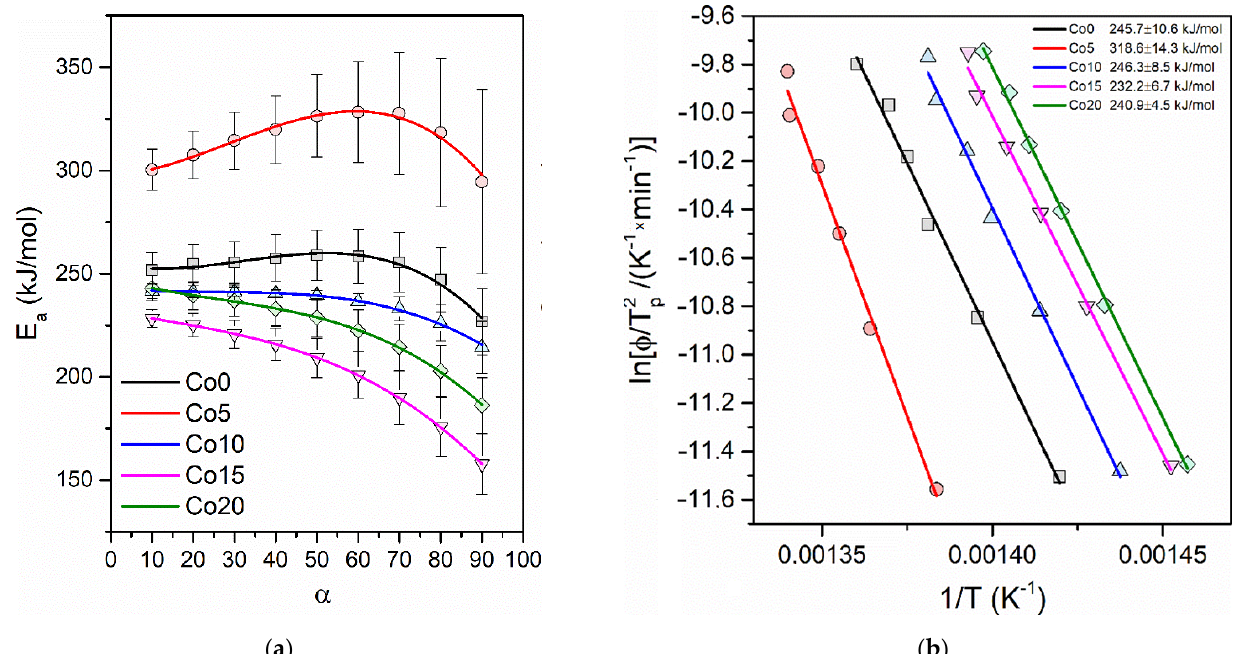
Figure 3. ( a ) The activation energy for the crystallization process derived from the FWO model related to the progress of crystallization; ( b ) The average values of the activation energies derived from the Kissinger model.